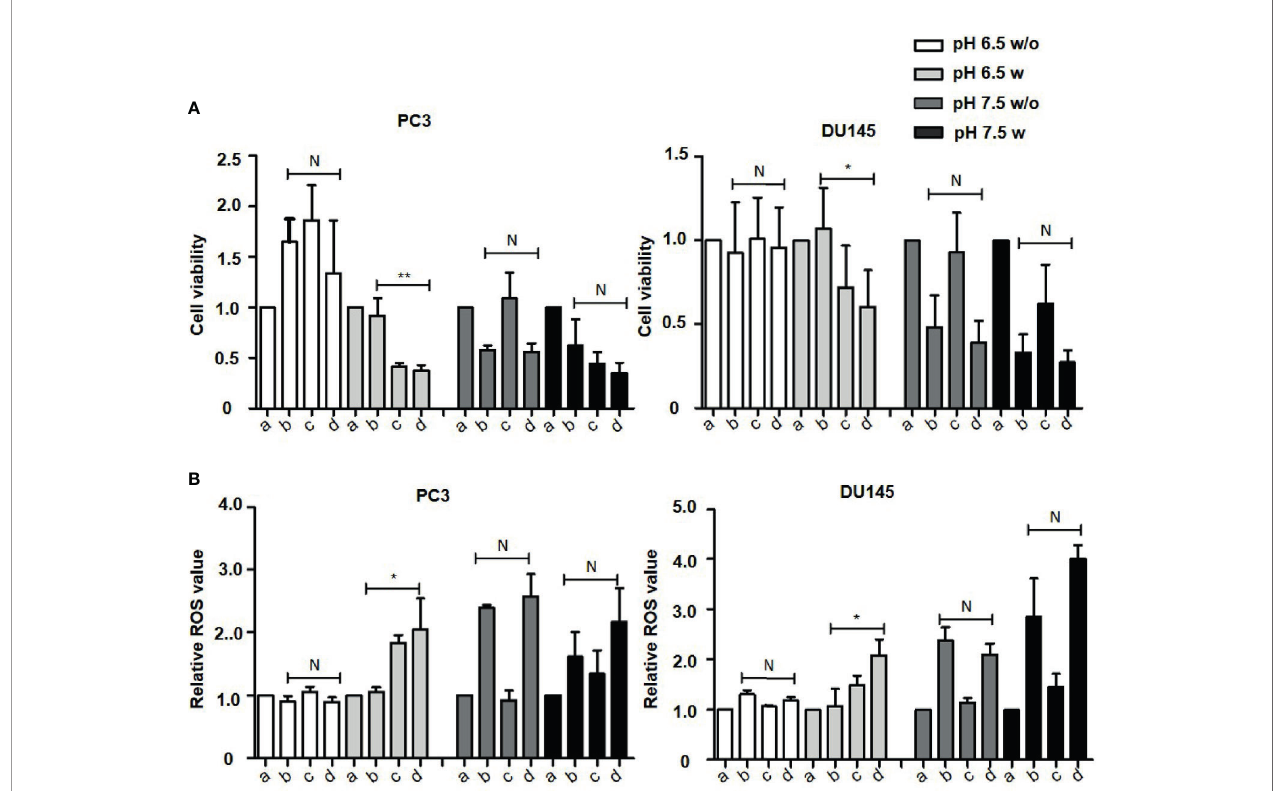
FIGURE 1 | Pantoprazole in combination with vitamin C inhibits cell proliferation and induces ROS accumulation. A total of 1x10 4 PC3 or DU145 cells per well (96-well plate) were incubated at 37°C with control (a), 4 mM vitamin C (b), 100 µM pantoprazole (c) or the combination of vitamin C and pantoprazole (d) for 4 h. Vitamin C was administered to cells with or without pretreatment with pantoprazole for 24 h (w: with pantoprazole pretreatment; w/o: without pantoprazole pretreatment). (A) Cell viability as assessed by the WST-8 assay and (B) ROS levels as detected based on fl uorescence intensity 1 h to 2 h after the addition of diluted ROS detection reagent to the cell culture medium. The cell viability and ROS levels in the control group (a) were de fi ned as 1.0. Any changes in cell viability and ROS levels following the different treatments are shown relative to the levels in the control group at two different pH values (pH 6.5 and 7.5, columns with different shades of grey). The bars represent the mean and SD of the mean of n ≥ 3. N, not signi fi cant; *p < 0.05; **p <